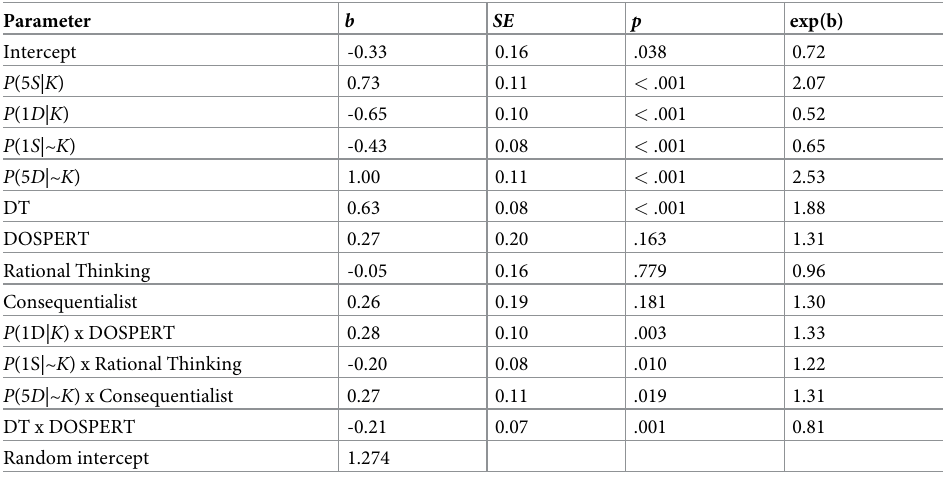
Table 3. Mixed-effects binary logistic regression predicting endorsing the kill option.